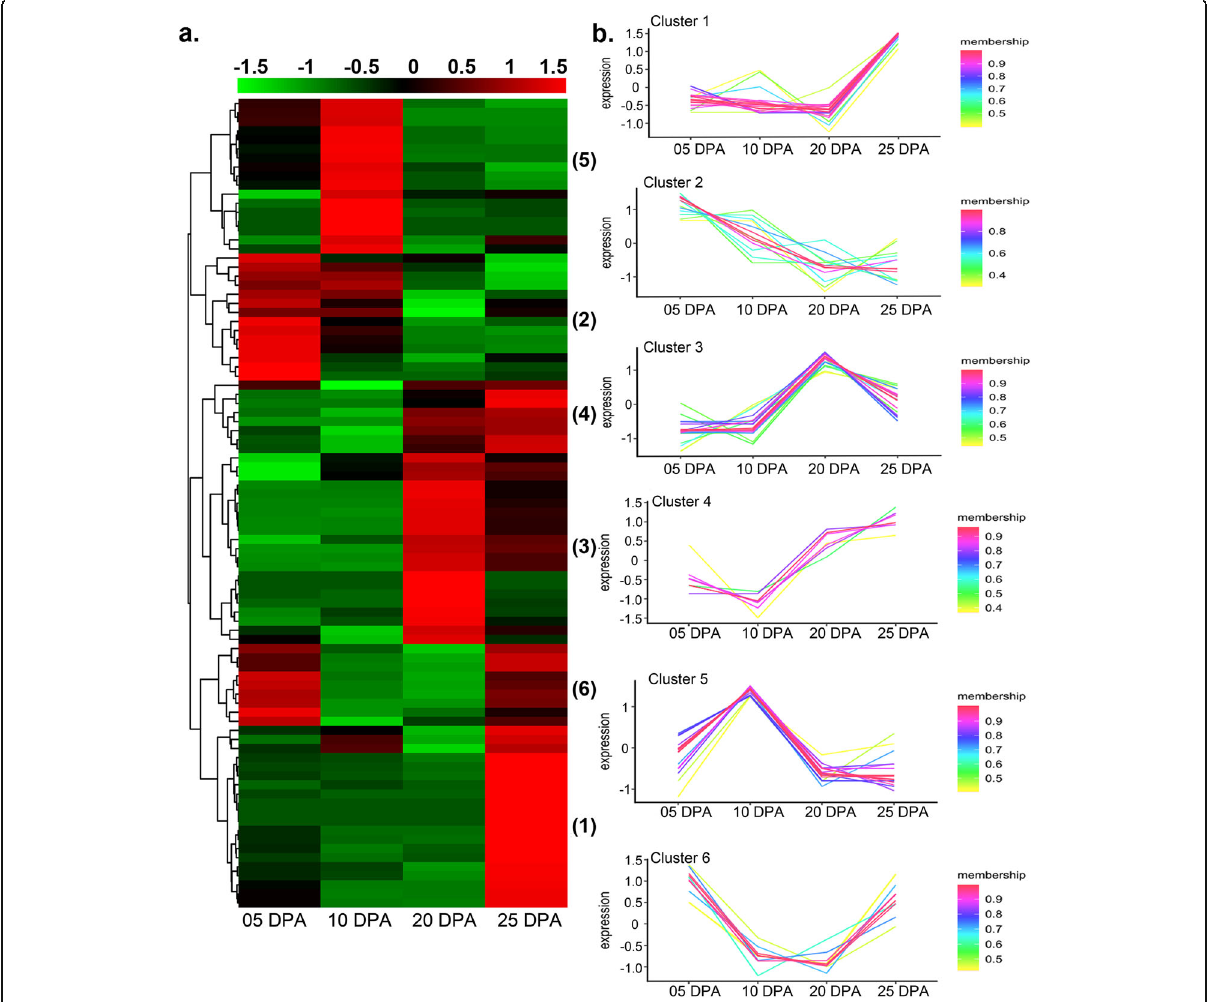
Fig. 4 Expression profiling of GhIQD genes during four developmental stages of the cotton fiber cell. a A hierarchical clustering heatmap of GhIQD gene expression in fiber cells at 5, 10, 20, and 25 DPA. These data were obtained from the transcriptome data available on the Cottongen website (https://www.cottongen.org/). The color scale represents the expression values, which have been normalized by the online software Omicshare b Gene expression of 89 GhIQD genes in six different clusters during four developmental stages of cotton fiber